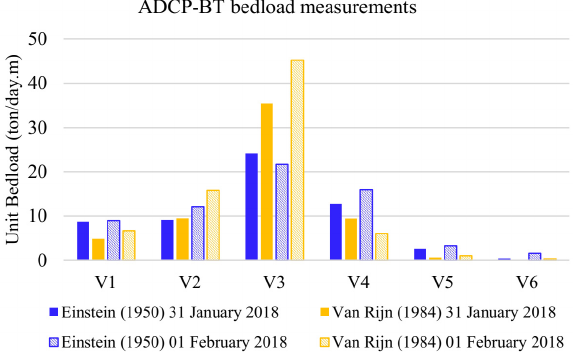
Figure 12. Unit bedload transport rates estimated with ADCP-BT, following Einstein [17] and Van